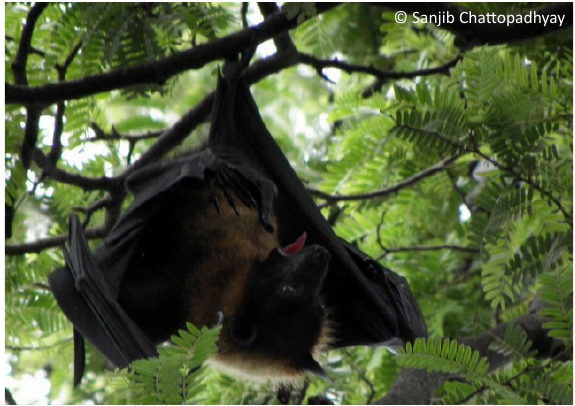
Image 2. Panting behaviour as a part of thermoregulatory mechanism shown by bats from the present study